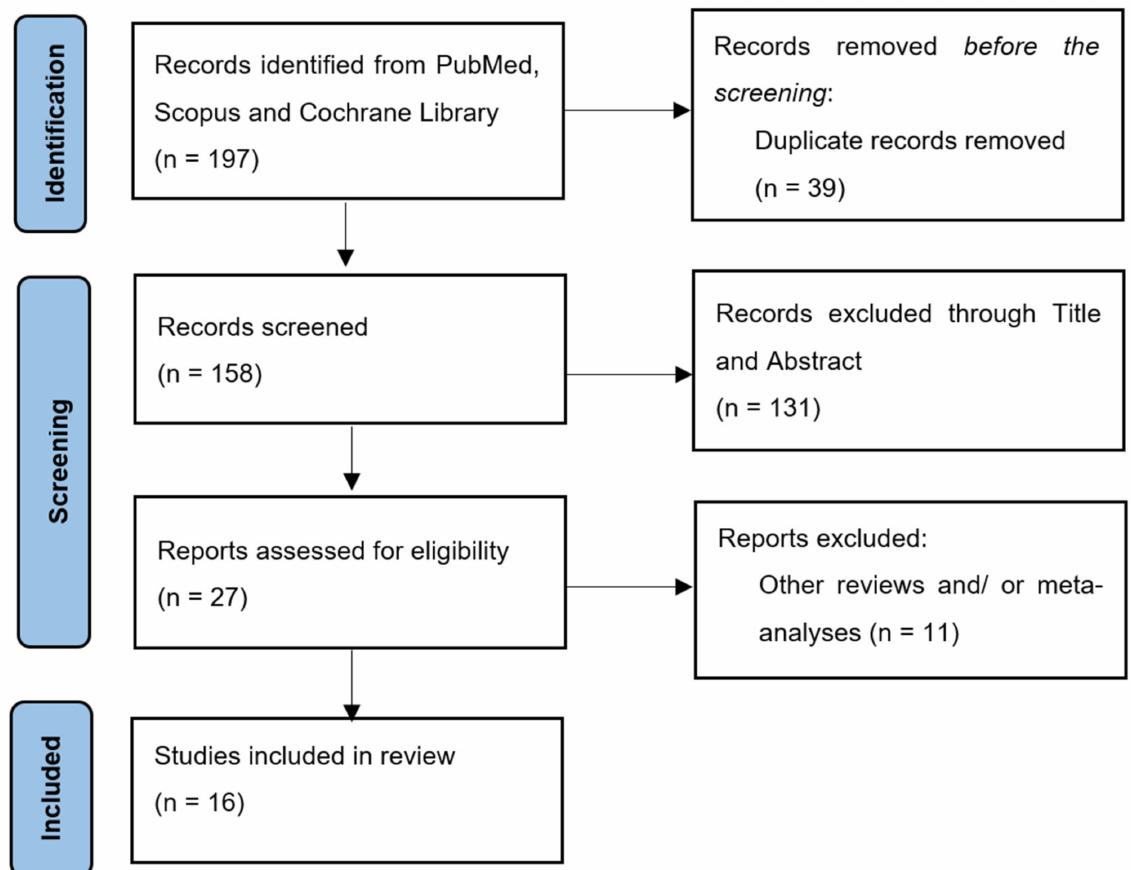
Figure 1. PRISMA flowchart for the selection